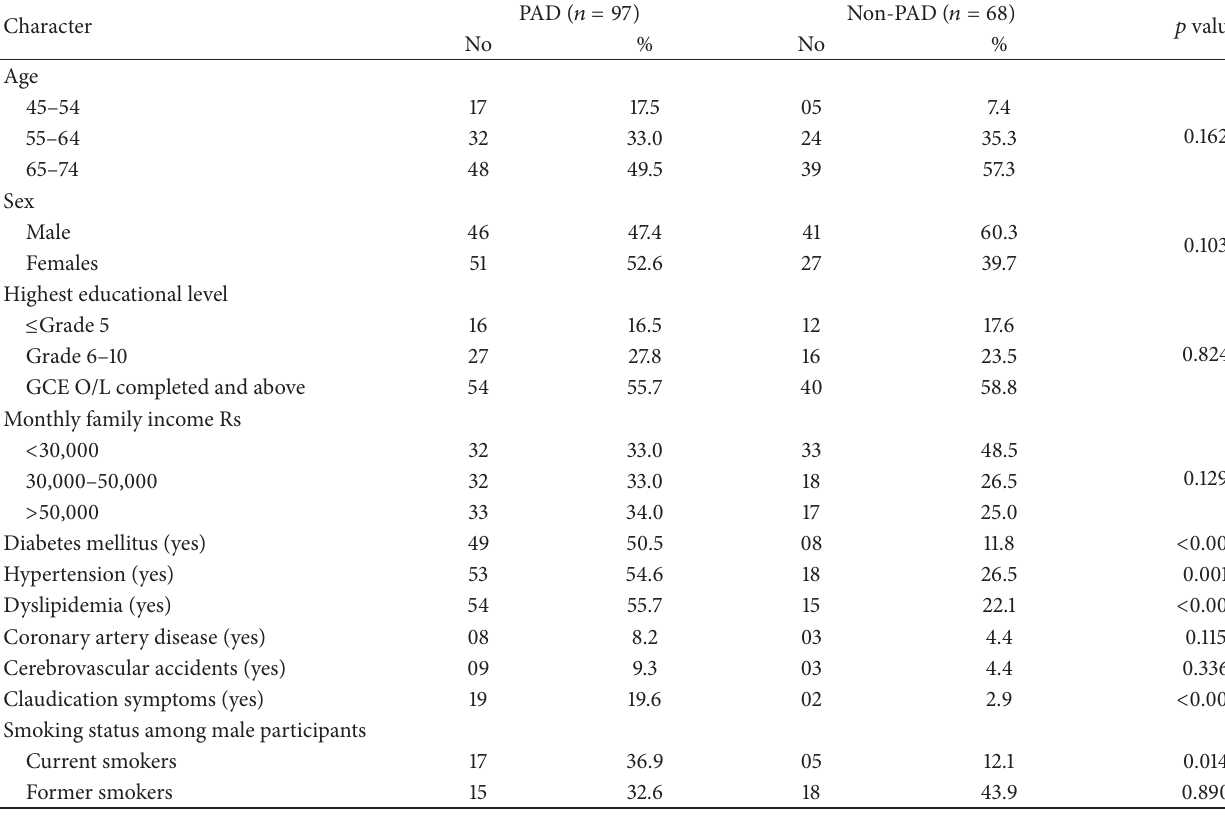
Table 1: Participant characteristics by presence of PAD.